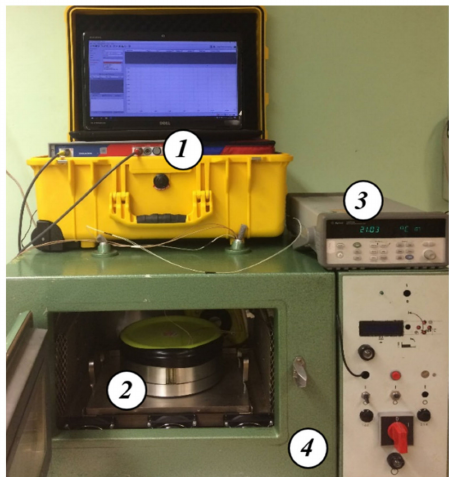
Figure 2. Photograph of the test stand for alternating current measurements of electrical properties of liquid–solid insulations [63]: 1—DS-PDC Dielectric Response Analyzer (Dirana meter), 2—three- electrode capacitor, 3—Agilent temperature meter, 4—climatic